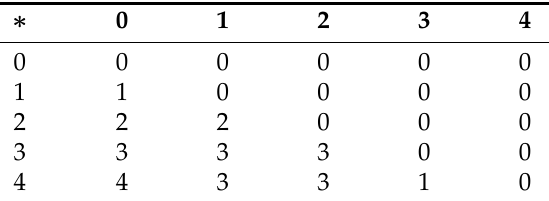
Table 7. Cayley table for the binary operation “ ∗